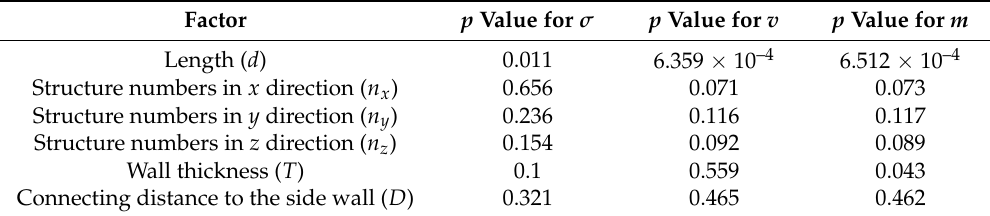
Table 9. The analysis results of p